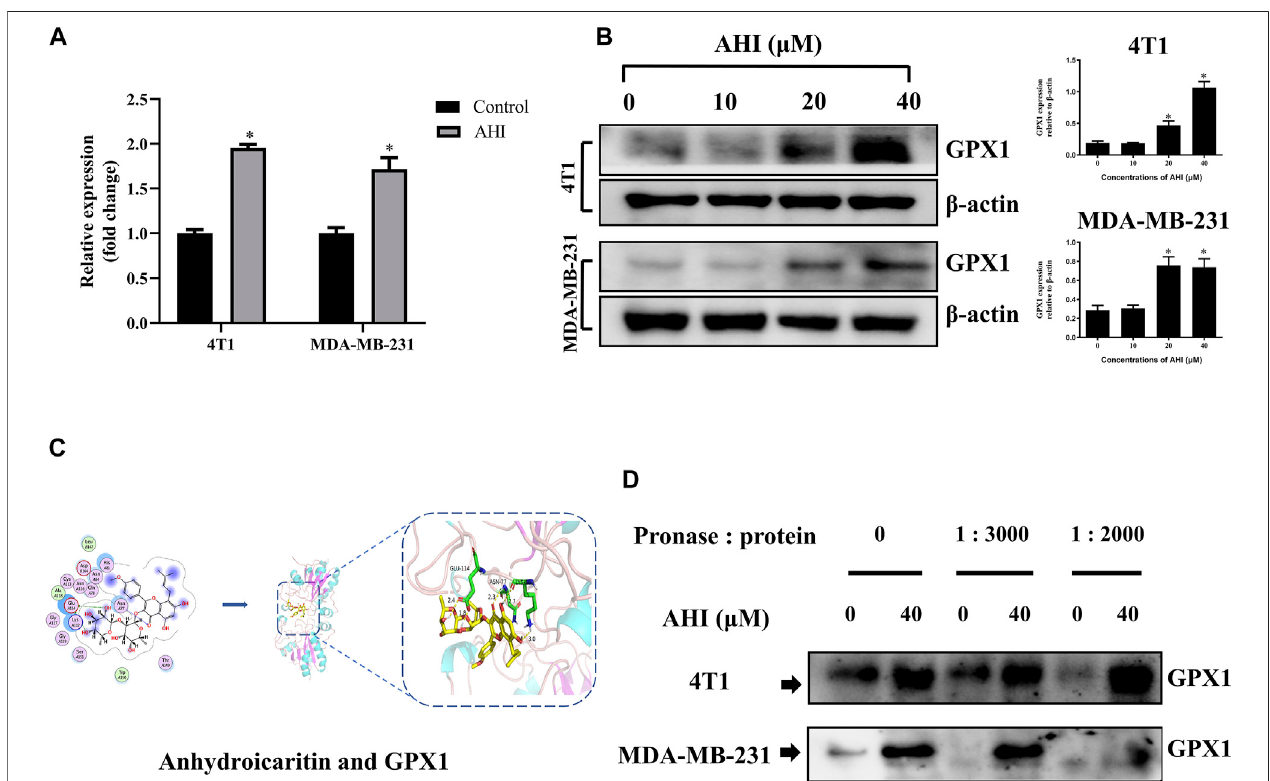
FIGURE5| GPX1wasthedrugtargetofAHIfortreatingBCcells. (A) RelativeGPX1expressionanalyzedbyRT-PCRafterAHItreatmentinthe4T1andMDA-MB- 231 cells. (B) Protein expression of GPX1 after treatment with different concentrations of AHI (* p < 0.05). (C) Combined prediction model of AHI and GPX1 domain. (D) DARTS assay was performed to test the direct binding of AHI to GPX1 in BC cells. * p < 0.05.